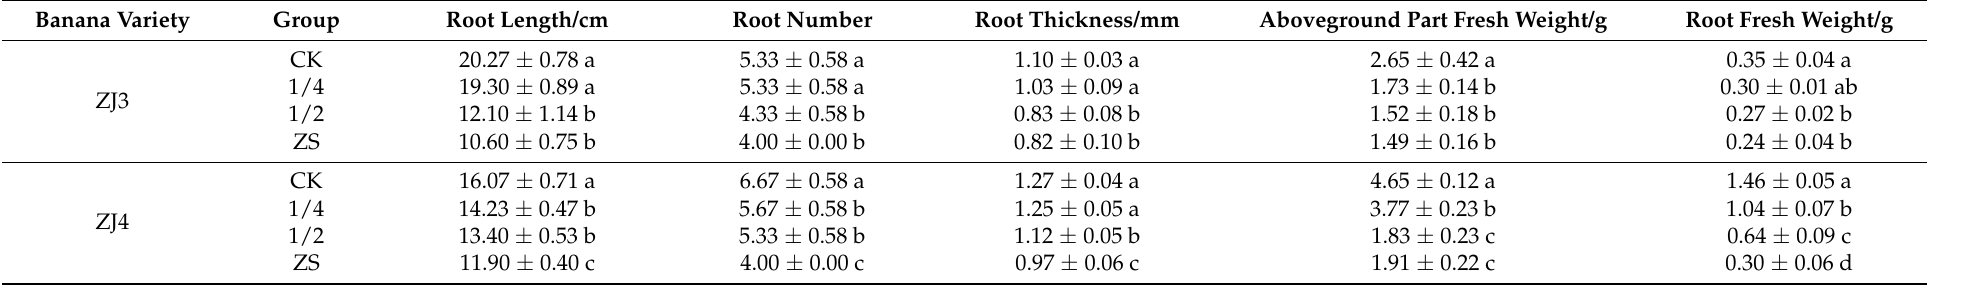
Table 3. Effects of bamboo fungus on the root growth parameters and biomass of ‘Zhongjiao No.3’ (ZJ3) and ‘Zhongjiao No.4’ (ZJ4) banana seedlings. CK: seedlings grown in nutrient soil; 1/4: seedlings grown in nutrient soil containing 1/4 bamboo fungus culture substrates; 1/2: seedlings grown in nutrient soil containing 1/2 bamboo fungus culture substrates; ZS: seedlings grown in bamboo fungus culture substrates. The different letters within the same column represent significant difference among samples at 0.05